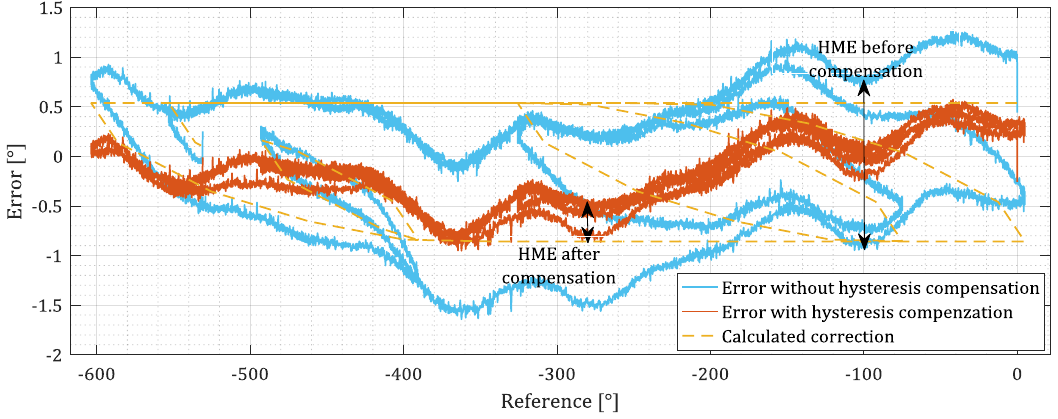
Figure 8. Error of the sensor with and without hysteresis compensation. Before the compensation, a noticeable gap between the error during upward and downward movement can be seen. The gap is decreased after the compensation is applied. The remaining error is mostly due to the imperfections of the magnetic scale.